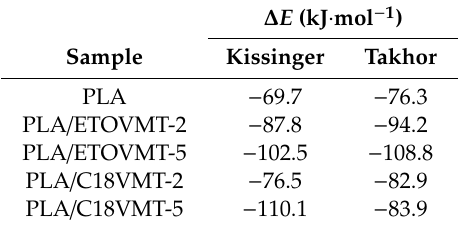
Table 4. The crystallization activation energy calculated from Kissinger and Takhor models for PLA and PLA /